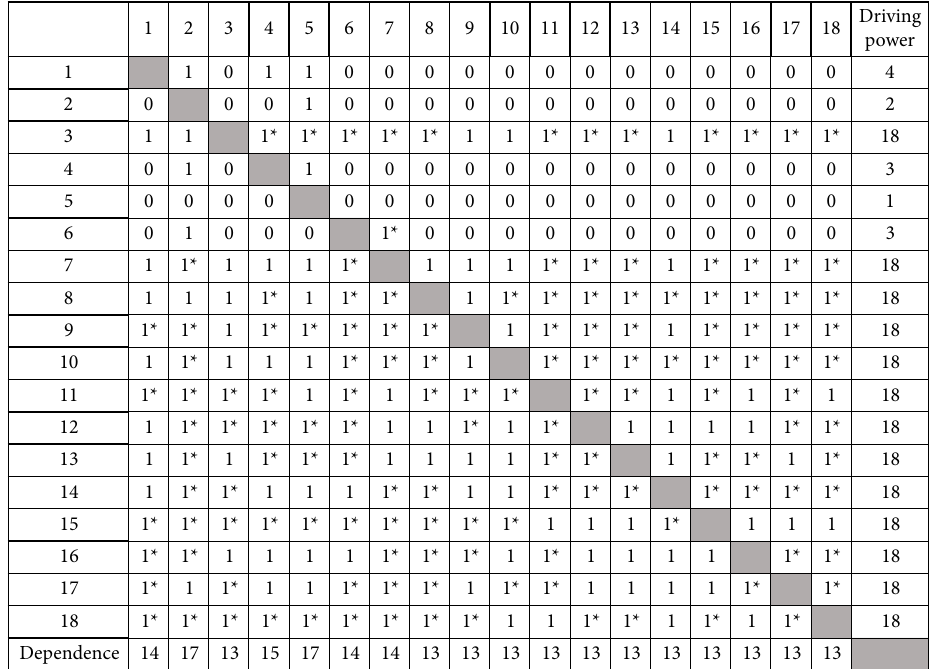
Table 5. SSIM of research variables for ISM